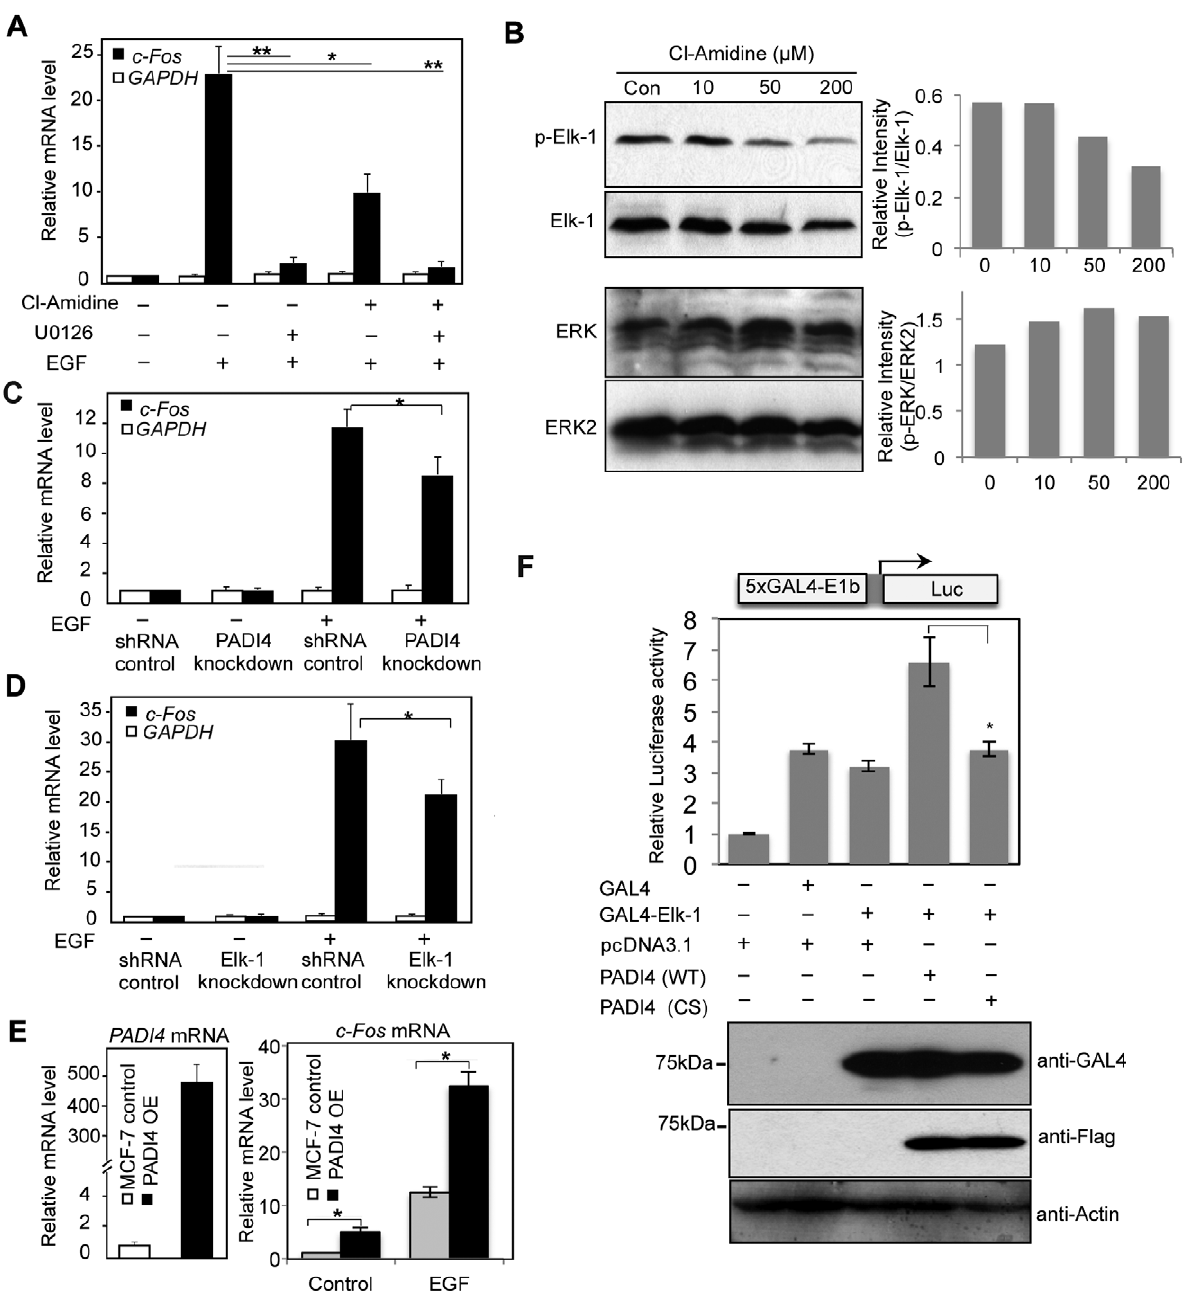
Figure 4. PADI4 mediates expression of the Elk-1 target gene c-Fos . (A, C and D) Real-time RT-PCR analysis of the c-Fos and GAPDH expression in serum-starved or EGF-stimulated MCF-7 cells (A) with or without Cl-Amidine or U0126 treatment; (C) with or without PADI4 knockdown; (D) with or without Elk-1 knockdown. Expression data are normalized to b -actin transcripts and the graph represents the mean + SEM (n=3). *P , 0.05, **P , 0.01. (B) Dose-dependent effect of Cl-Amidine treatment on Elk-1 activation and ERK2 phosphorylation in MCF-7 cells. Different doses of Cl- Amidine were added to the normal MCF-7 cell culture media for 48 hours and western blots of cell lysates were then performed using anti-p-Elk-1, anti-Elk-1, anti-p-ERK and ERK2 antibodies. The graph on the right is a semi-quantitative analysis of the western blots (relative intensity) with an arbitrary number of the intensity ratio of p-Elk-1 compared to total Elk-1, or p-ERK compared to total ERK2 using Image J software. (E) Stable overexpression (OE) of PADI4 in MCF-7 cells increases transcriptional output of c-Fos . Left: qRT-PCR analysis showing that PADI4 expression is increased in PADI4 OE MCF-7 cells. Right: qRT-PCR analysis showing that c-Fos transcription output was significantly elevated in PADI4 OE MCF-7 cells under either control or EGF treatment. (F) PADI4 enzymatic activity facilitates Elk-1 mediated gene transcription. Expression vector for the DNA- binding domain of GAL4 (CMV-GAL4) or GAL4-Elk-1 was transfected into HEK293 cells along with the 5xGAL4-driven luciferase reporter plasmid containing the minimal E1b promoter and plasmids for pcDNA3.1, wild type (WT) or inactive mutant (C645S) PADI4 with N-terminal Flag tags. Luciferase activity was determined per microgram total cell protein 24 hours after transfection and results are represented as fold relative to empty vector control. Data shown are representative of two independent experiments performed in triplicate and error bars indicate SEM. *P , 0.05 (two- tailed paired Student’s t-test). In the lower panel, the expression of Flag-PADI4 and GAL4-Elk-1 fusion proteins was monitored by western blot using anti-Flag and anti-GAL4 antibodies.